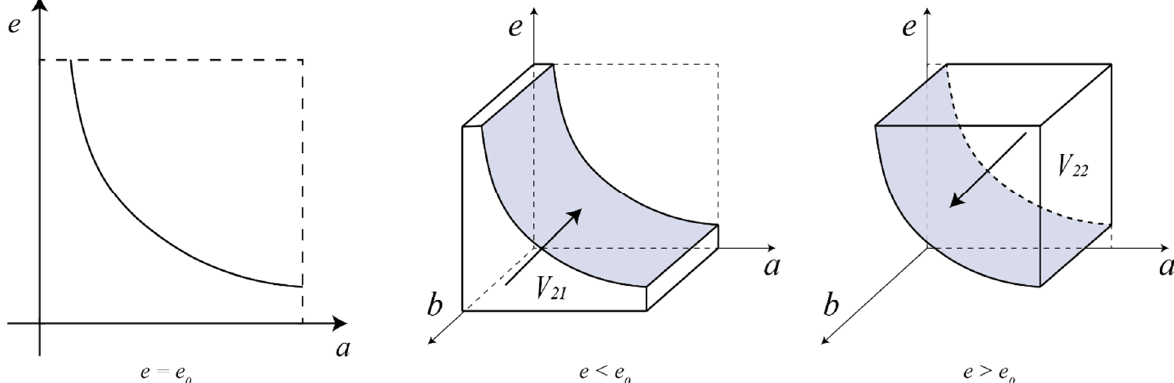
Figure 4. Strategy selection phase diagram of property developers.